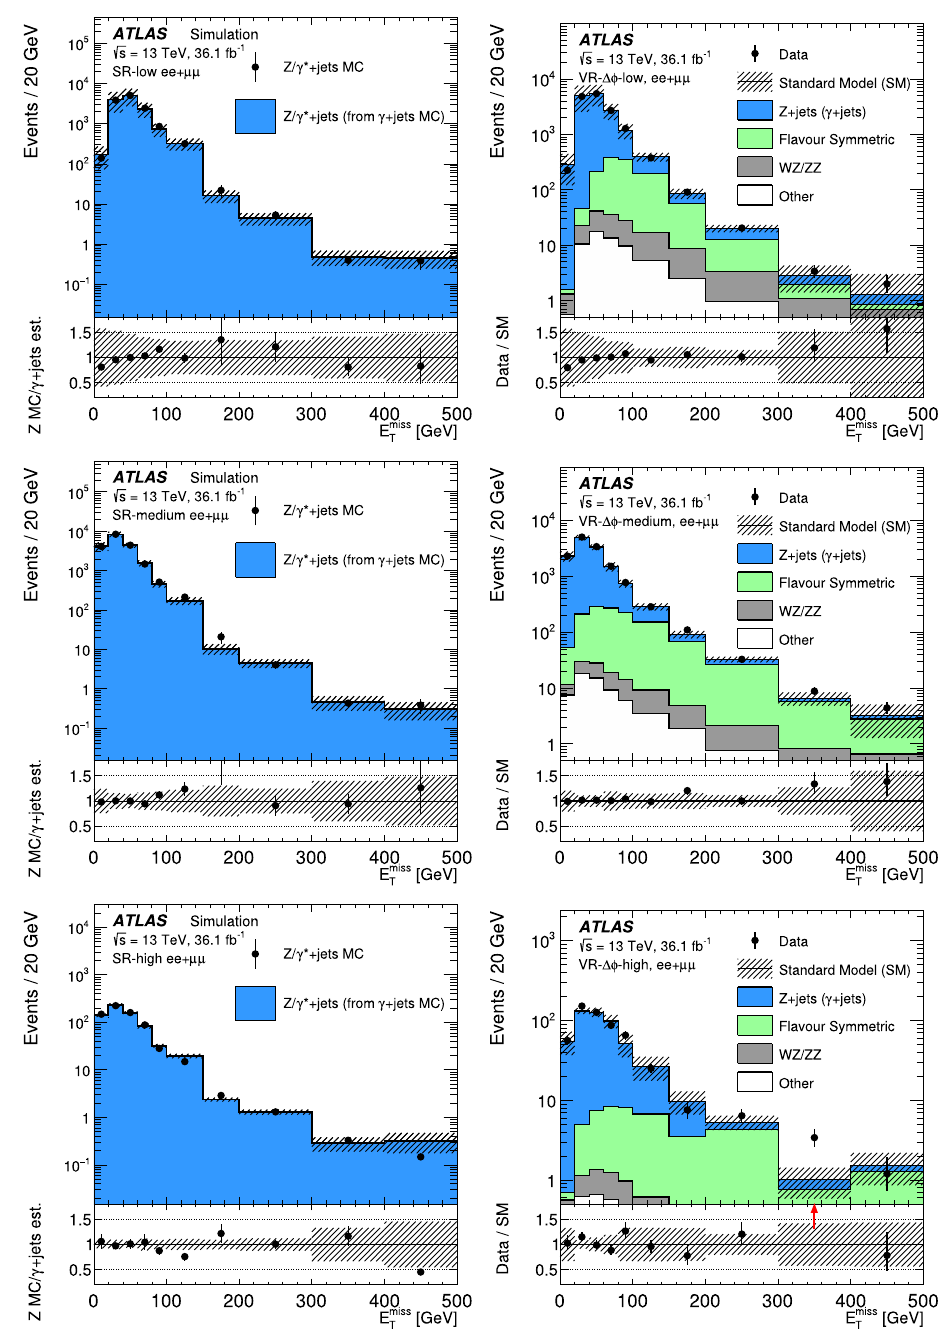
Fig. 6 Left, the E miss spectrum in Z /γ ∗ + jets MC simulation com- spectrum when the method is applied to data in VR- (cid:7)φ -low (top), VR- T (cid:7)φ -medium (middle) and VR- (cid:7)φ -high (bottom). The bottom panel of pared to that of the γ + jets method applied to γ + jets MC simu- lation in SR-low (top), SR-medium (middle) and SR-high (bottom). each figure shows the ratio of observation (left, in MC simulation; right, No selection on E miss indata)toprediction.Incaseswherethedatapointisnotaccommodated is applied. The error bars on the points indicate T by the scale of this panel, an arrow indicates the direction in which the the statistical uncertainty of the Z /γ ∗ + jets MC simulation, and the point is out of range. The last bin always contains the hashed uncertainty bands indicate the statistical and reweighting sys- tematic uncertainties of the γ + jet background method. Right, the E miss T